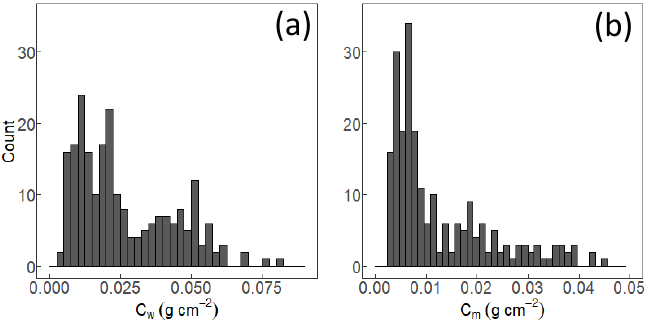
Figure 3. Histogram of C w ( a ) and C m ( b ), measured on 225 leaf samples grown in controlled conditions.